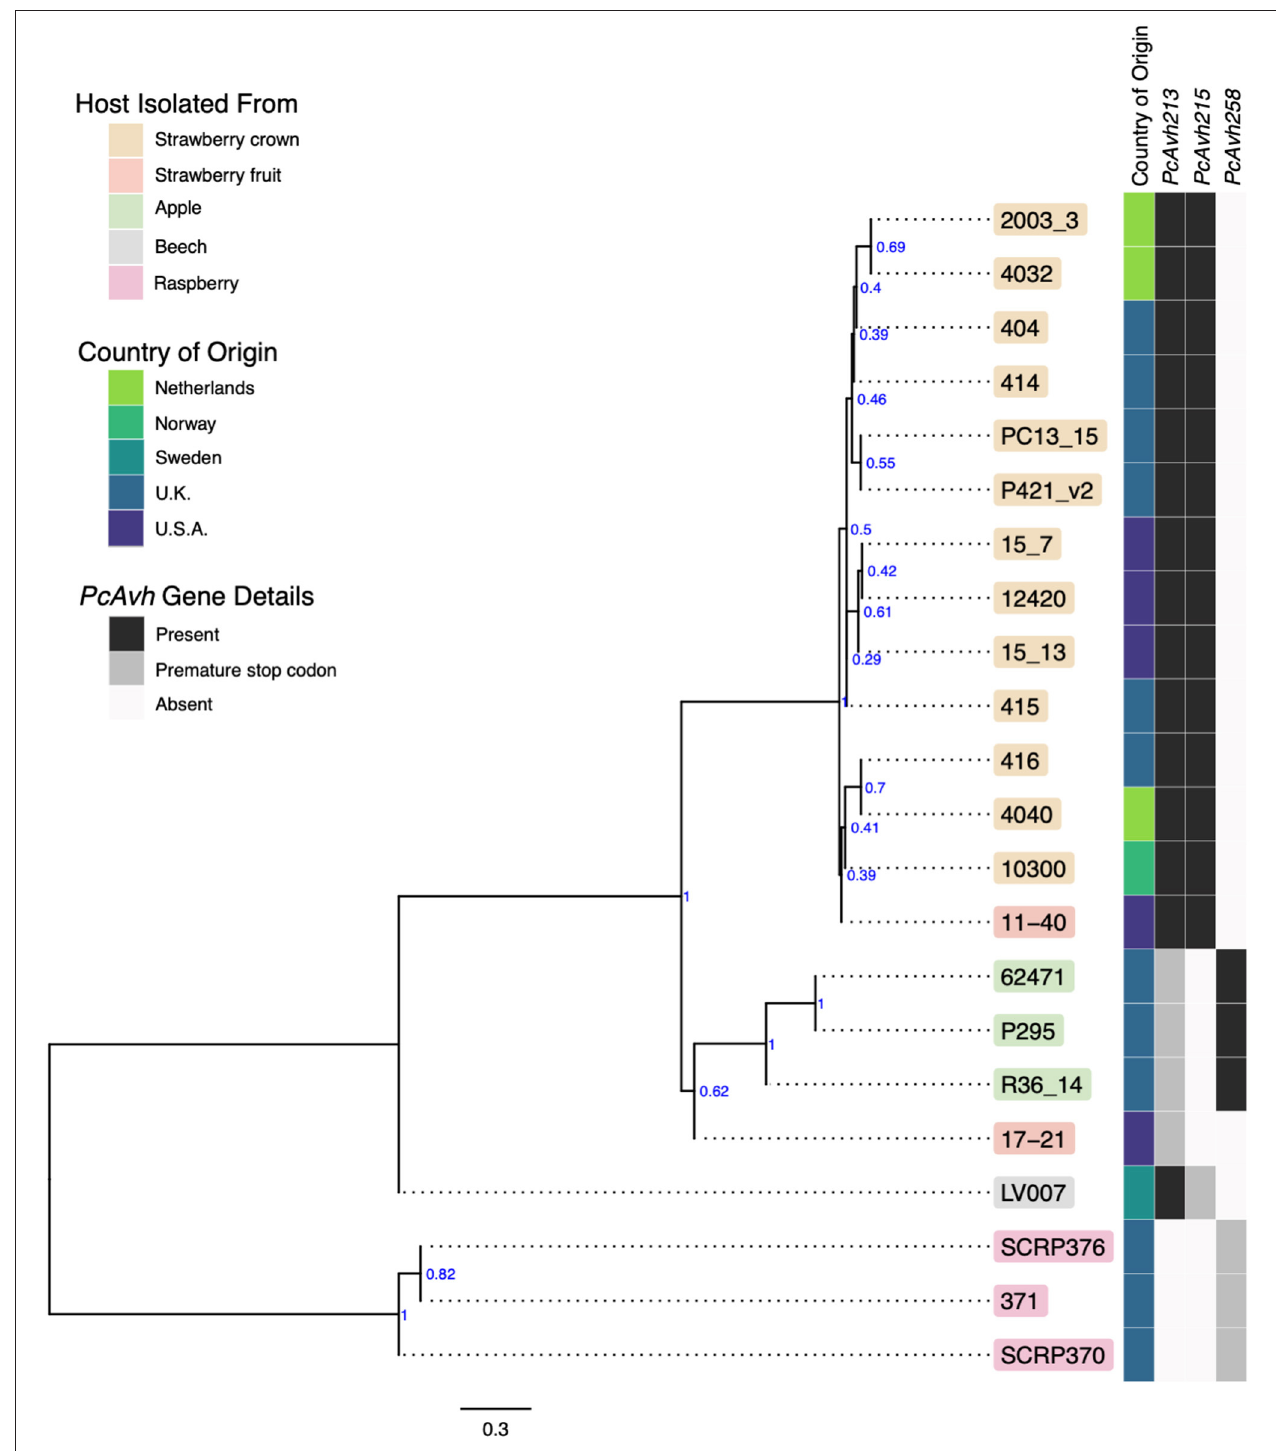
FIGURE 2 | Apple and strawberry crown rot Phytophthora cactorum isolates form distinct clades. Maximum parsimony consensus phylogeny of 230 Alveolata-Stramenopiles Benchmarking Universal Single-Copy Orthologue (BUSCO) genes from 22 Phytophthora isolates. Branch support shown in blue. Details of the host species isolated from, country of origin and presence/absence of a Phytophthora sojae Avh32 homologue ( PcAvh215 ) and Phytophthora infestans Avr3a homologue ( PcAvh258 ) and PcAvh213 are shown in the heatmap.